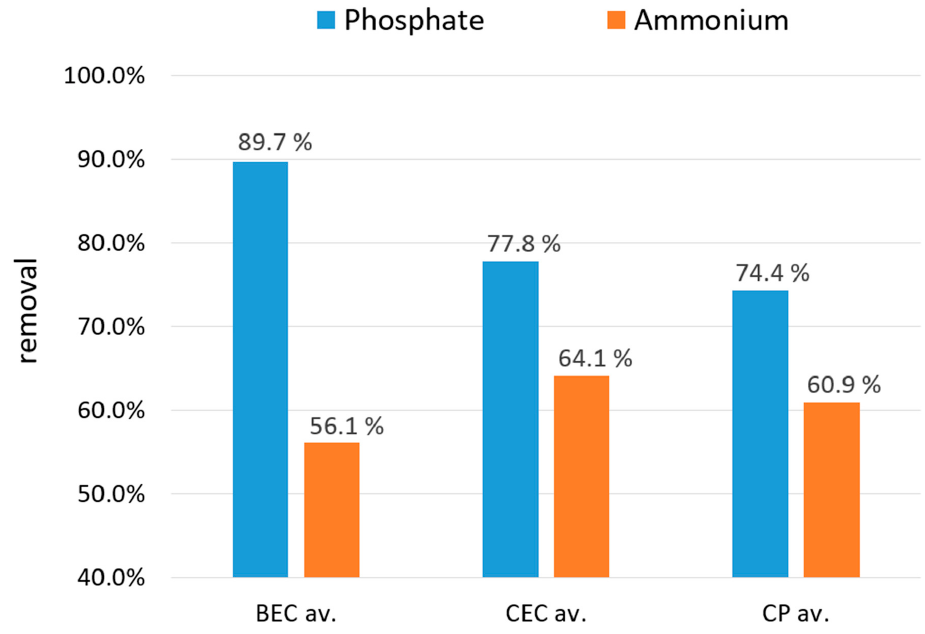
Figure 6. Average phosphate and ammonium removal rates of the BEC, CEC, and CP in authentic water treatment. BEC av., batch electrocoagulation average value; CEC av., continuous electrocoagulation average value; and CP av., chemical precipitation average value.